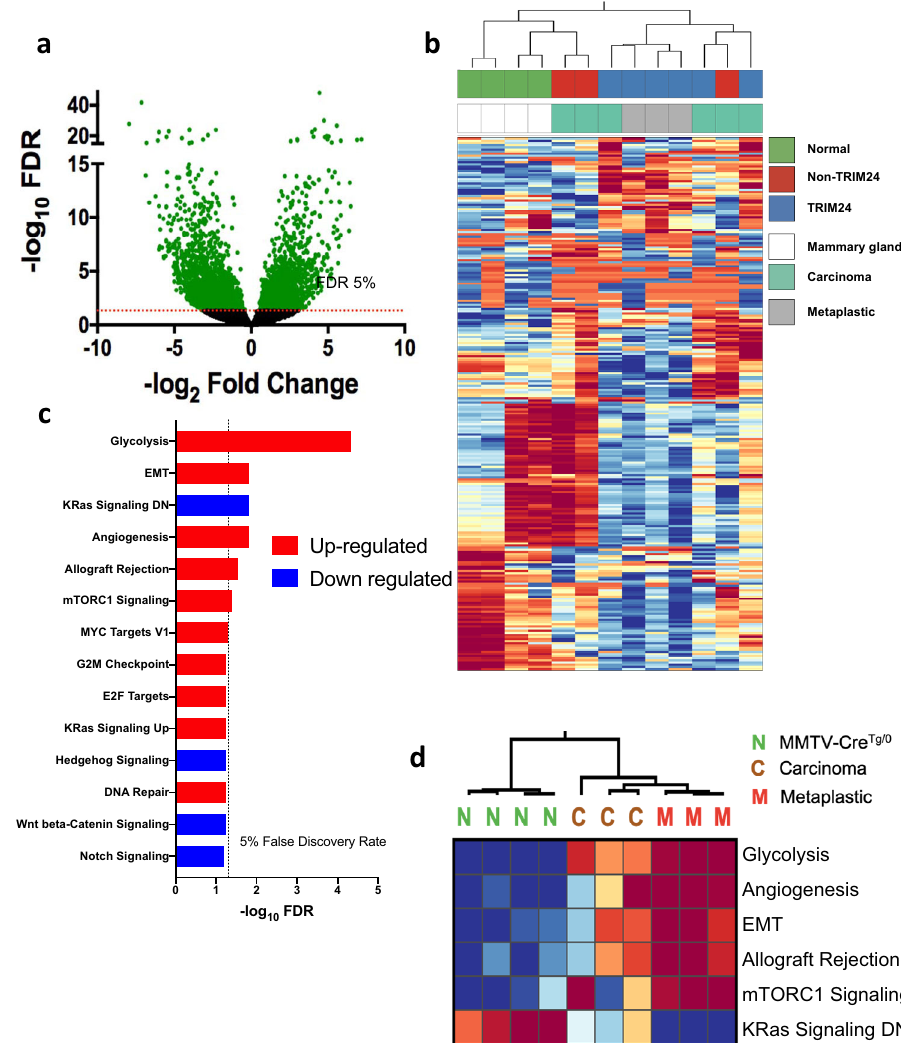
Fig. 3 TRIM24 over-expression drives expression of EMT-related genes. a Volcano plot of all genes. Green dots represent all genes which exceeded FDR cutoff. Y-axis represents − log 10 of FDR and X-axis represents – log 2 fold change; genes up-regulated on the right and genes down-regulated on the left. Dashed line represents FDR < 0.05 threshold b Unsupervised hierarchical clustering identi fi es three distinct groups from RNA deep sequencing. The heatmap is prepared using diverging scale where up-regulated genes are in red and down-regulated genes are in blue. The fi rst group represents MMTV- Cre Tg/0 mammary glands (green), second cluster is Trim24 COE driven mammary tumors (both carcinomas and metaplastic carcinosarcomas), and the third group is mixed non-TRIM24 driven mammary tumors and Trim24 COE carcinomas. These clusters are further classi fi ed into normal MMTV-Cre Tg/0 mammary glands (white), carcinomas (teal), and metaplastic carcinosarcomas (gray). c Gene set enrichment analysis of up-regulated (red) and down- regulated (blue) differentially expressed pathways between Trim24 COE metaplastic carcinosarcoma tumors compared to MMTV-Cre Tg/0 mammary glands. The dotted line represents FDR < 0.05 threshold. d Heatmap of top differentially expressed pathways calculated by ssGSEA scores between N - MMTV- Cre Tg/0 mammary glands, C - Trim24 COE carcinomas and M - Trim24 COE metaplastic carcinosarcoma (Supplementary Fig. 3d), predicting that TRIM24 is activated in human metaplastic tumors. Previously a mouse model with MMTV-driven expression of Hepatocyte Growth Factor Receptor Met tyrosine kinase was reported to develop diverse EMT-high and claudin-low, metaplastic carcinosarcoma tumors 27,30 . Com- parison of our calculated TRIM24 metaplastic score to microarray expression analysis of MMTV-Met-driven and MMTV- Met;Trp53 fl / + tumors revealed that the TRIM24 signature is signi fi cantly higher in the two MET-driven metaplastic models, but not the non-metaplastic p53/MET model (Supplementary Fig. 3e). Next, the association between TRIM24-driven metaplastic carcinosarcoma tumors and a previously reported human MpBC gene expression signature was calculated using GSEA 12 . This